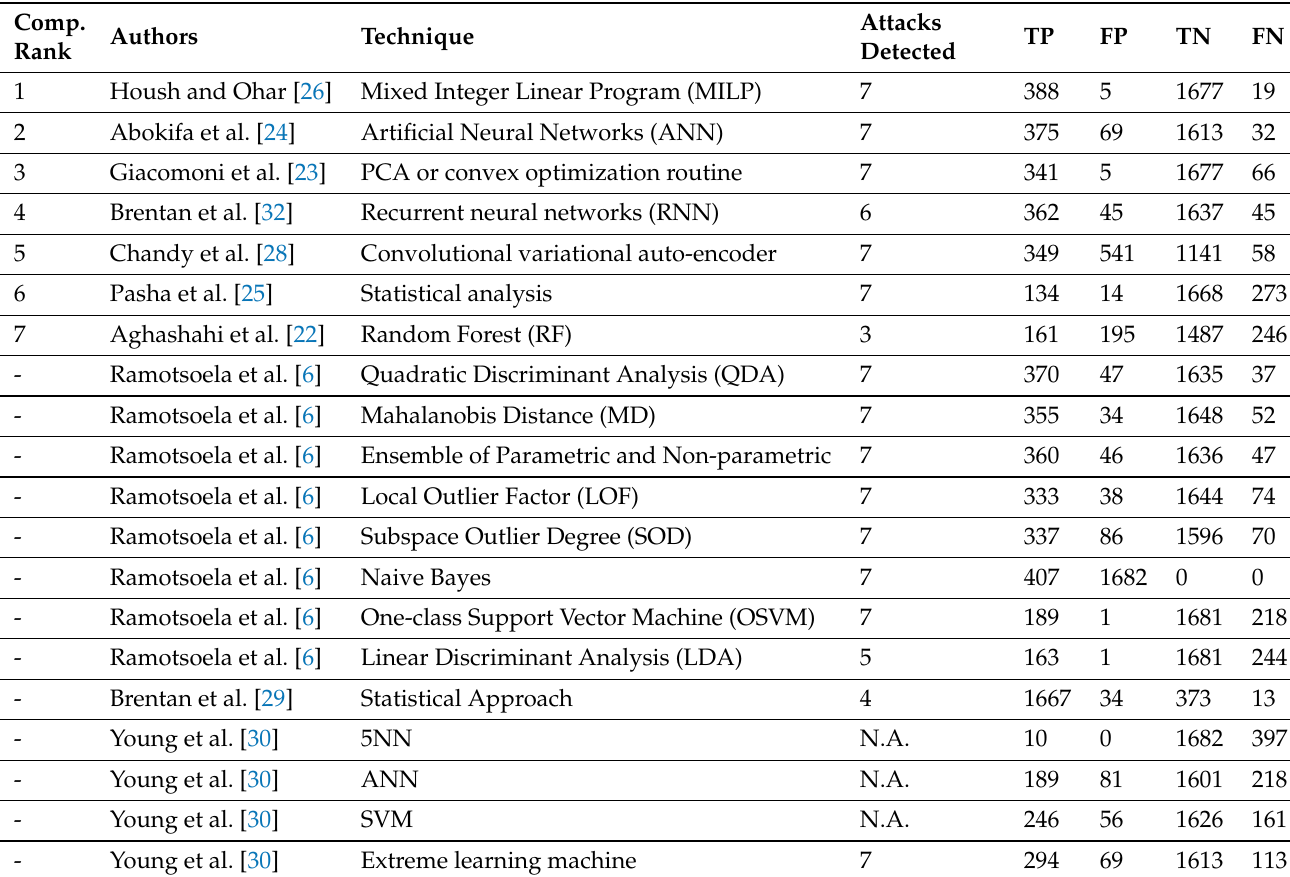
Table 1. Comparison of algorithms that used on BATADAL